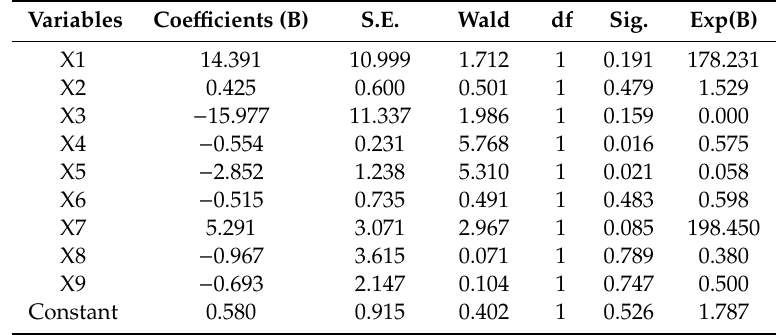
Table 6. Variables in the equation of logit model.